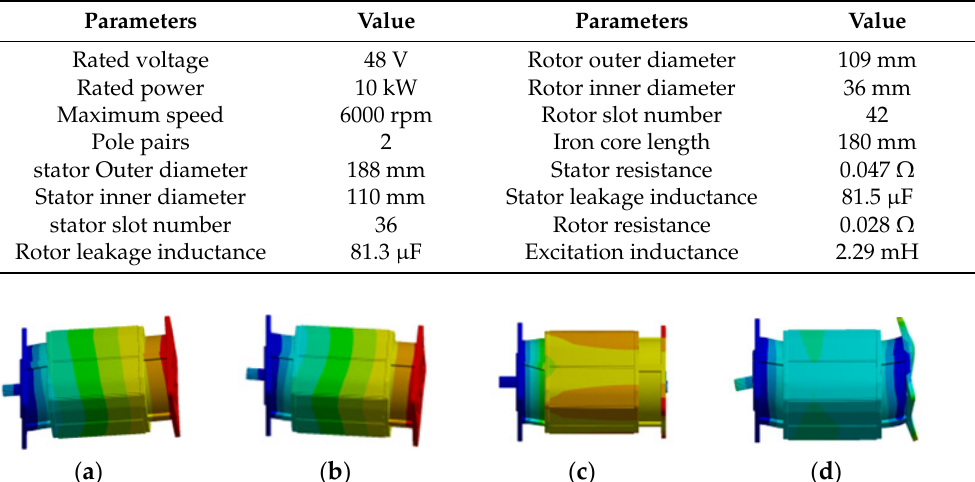
Figure 2. Simulation of the IM natural frequency. ( a ) 1st order modal; ( b ) 2nd order modal; ( c ) 3rd order modal; and ( d ) 4th order modal. Table 1. The parameters of the IM.